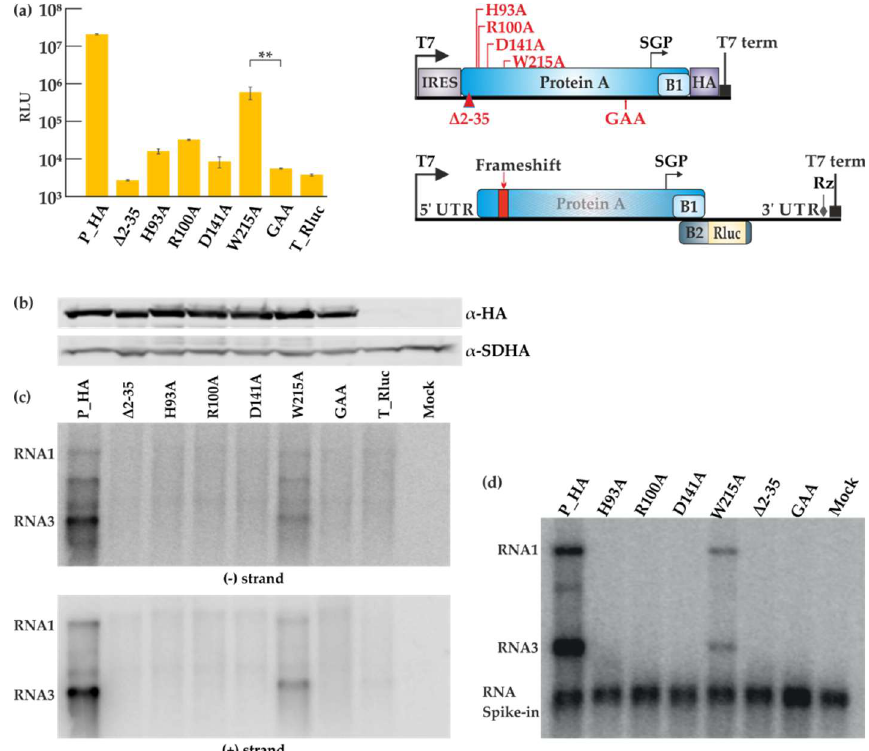
Figure 4. Mutational analysis of the FHV RNA capping enzyme. ( a ) BSR T7/5 cells were co-transfected with each FHV protein A mutant construct and template construct T_Rluc. Rluc activity was measured 40 h post-transfection. Mock values have been subtracted, error bars represent the standard deviation and ** designates p < 0.01 (Student’s t test). The location of the mutations is shown schematically on the right. RLU: relative light units. ( b ) Expression of protein A variants as detected by Western blotting with anti-HA antibodies; SDHA was used as a control. ( c ) Viral RNA synthesis detected by Northern blotting for minus and plus strands as indicated. ( d ) CMP fractions were isolated from transfected cells and used in the IVRA. The spike-in of short radioactive RNA was used to ensure equal isolation and loading of RNA. The relative density of the bands was measured with ImageJ software.